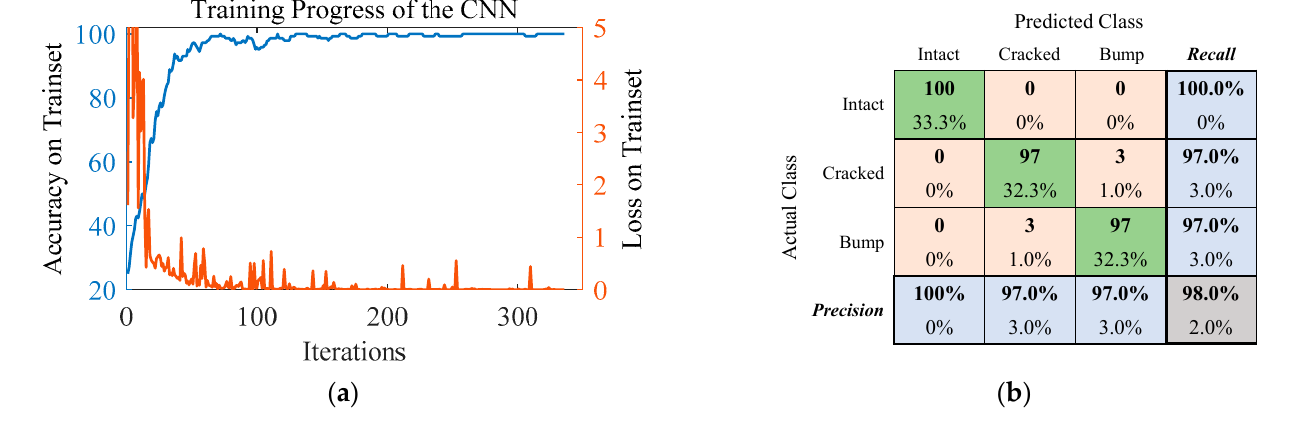
Figure 13. Classification results of the CNN: ( a ) The training accuracy and loss on trainset; ( b ) The confusion matrix of the validation results.